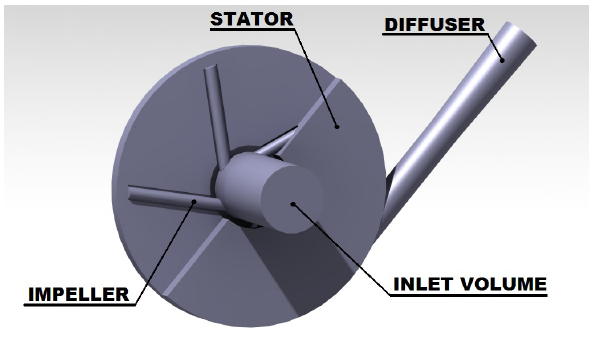
Figure 6: Simplified model of flow geometry of a multi-piped pump with an annular